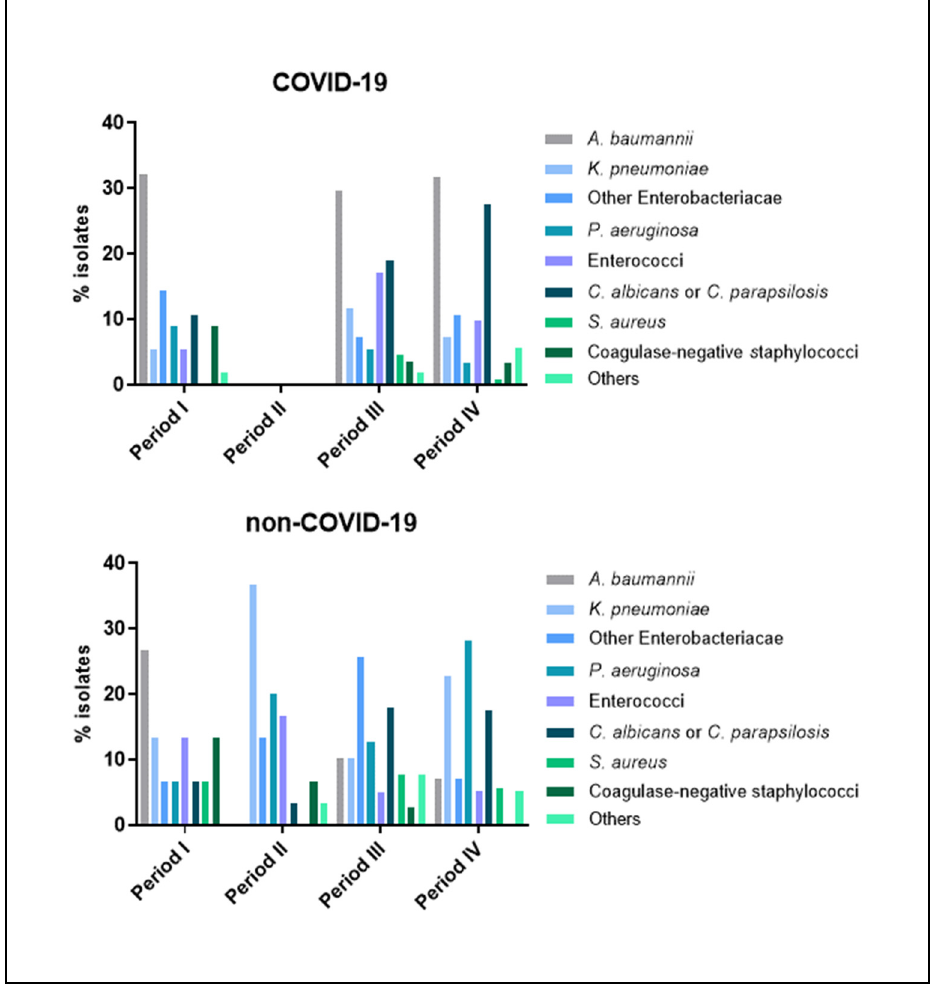
Figure 3. Microorganisms responsible for healthcare-associated infections (HAIs) isolated in patients admitted to the Intensive Care Unit of Umberto I teaching hospital of Rome between 1